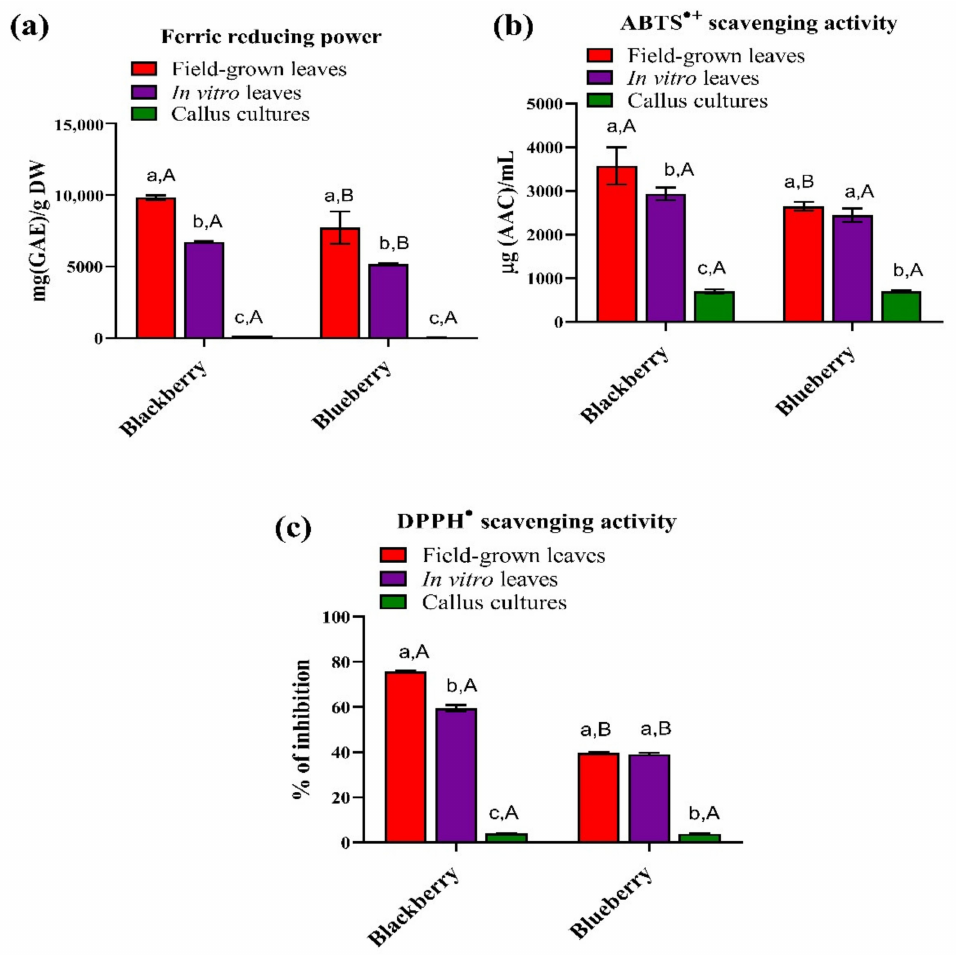
Figure 3. ( a ) Ferric reducing power (FRP), ( b ) ABTS • + radical scavenging activity, and ( c ) DPPH • radical scavenging activity of field-grown leaves, in vitro leaves and callus cultures of blackberry ‘ ˇCaˇcanska Bestrna’ and blueberry ‘Toro’. The bars with ( ± ) standard deviation represent mean values. The different lowercase letters indicate a significant difference ( p < 0.05) between field-grown leaves, in vitro leaves and callus culture of the same berry. Different uppercase letters indicate a significant difference ( p < 0.05) between the same types of samples of two different